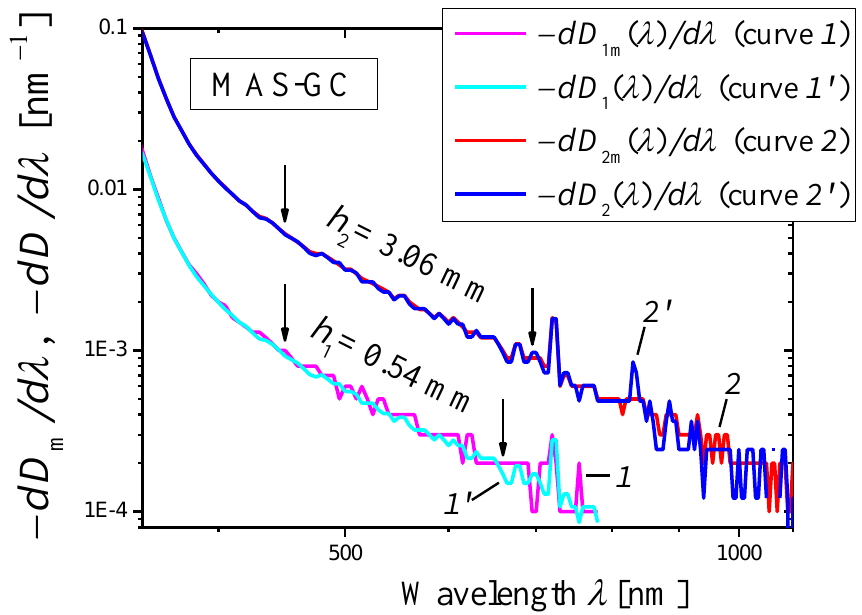
(cid:2) ( − dD ( λ ) / d λ ) (cid:3) − (cid:2) log ( λ ) (cid:3) (curves 1 and 2 ) and Figure 15. The plots of log i m 10 10 (𝜆)] (curves 1 and 2 ) and [log (−𝑑𝐷 𝑖 (𝜆)/𝑑𝜆)] − [ log Figure 15. The plots of [ log [ log ( − dD ( λ ) / d λ )] − [ log ( λ ) (cid:3) (curves 1 (cid:48) and 2 (cid:48) ) for the thin ( i = 1, curves 1 and 1 (cid:48) ) and thick m 10 10 i 10 10 (𝜆)] (curves 1 ′ and 2 ′ ) for the thin ( 𝑖 = 1 , curves 1 and 1 ′ ) and thick ( 𝑖 = 2 , curves 2 and 𝑑𝜆)] − [log ( i = 2, curves 2 and 2 (cid:48) ) samples of MAS-GC (Section 10 2 ′ ) samples of MAS-GC (Section 2.2.4).